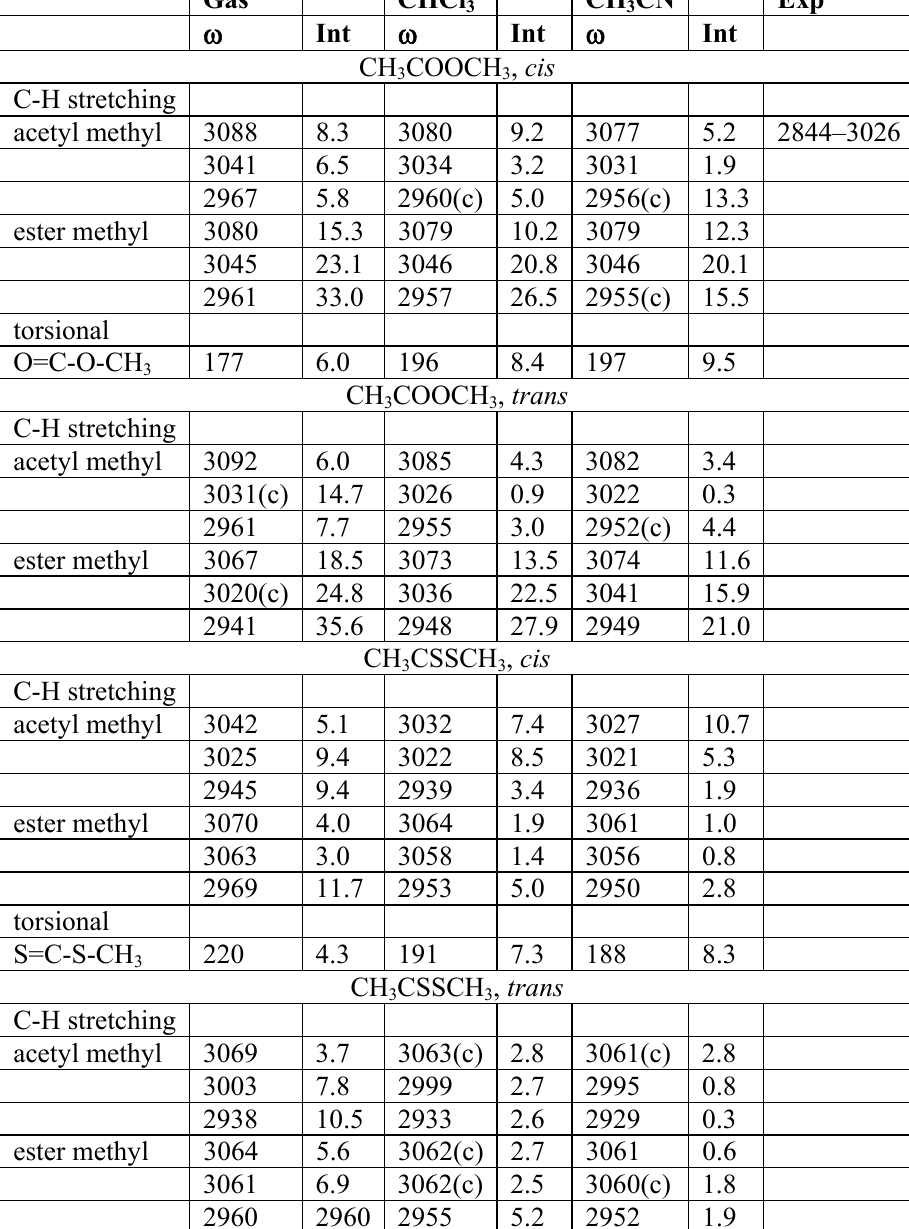
a COOCH and CH CSSCH 3 3 3 3